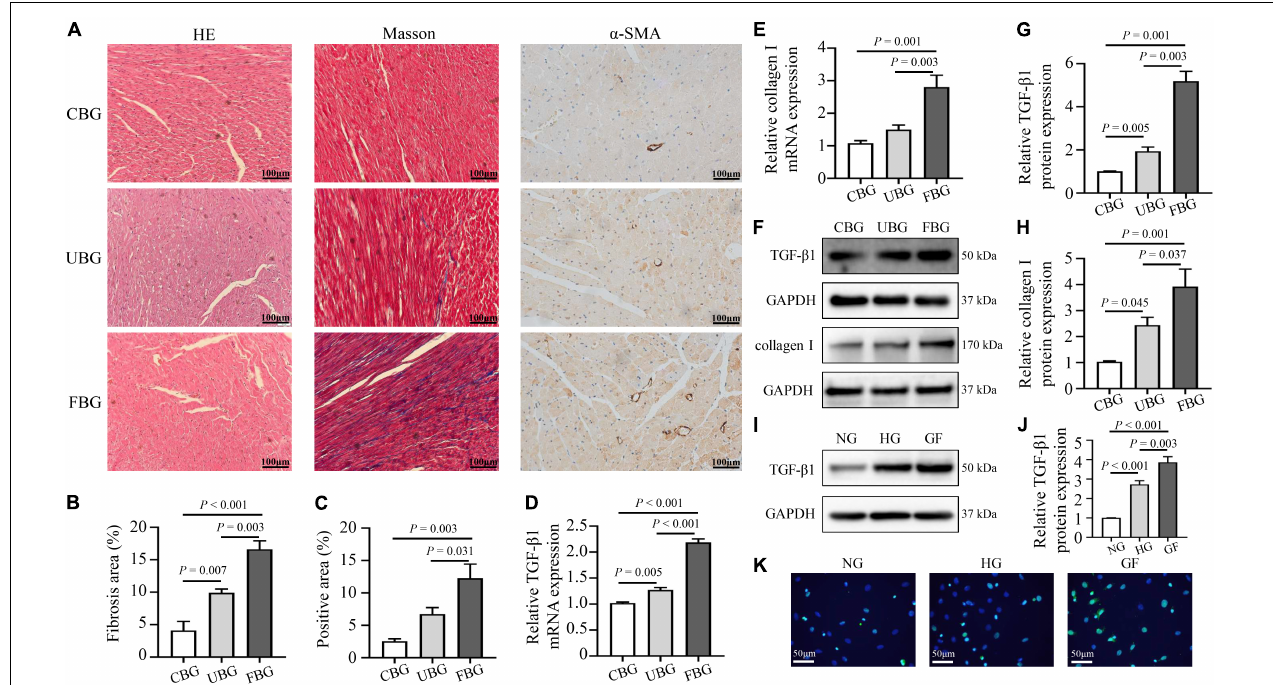
FIGURE 2 | Glucose fluctuations promoted myocardial fibrosis. (A–C) Representative images of hematoxylin and eosin (HE) staining for myocardial tissue in the CBG, UBG, and FBG groups ( n = 3 per group). Representative images of myocardial fibrosis and fibrosis area (%) in the CBG, UBG, and FBG groups ( n = 3 per group). Representative images of immunohistochemistry staining of α -SMA and positive area (%) in the three groups ( n = 3 per group). (D,E) The mRNA levels of TGF- β 1 and collagen I in rat hearts of the three groups ( n = 4 per group). (F–H) The protein expressions of TGF- β 1 and collagen I in rat hearts of the three groups ( n = 4 per group). (I,J) The protein expressions of TGF- β 1 in NRCFs of the NG, HG and GF groups ( n = 4 per group). (K) Immunofluorescence staining of intracellular TGF- β 1 in the NG, HG, and GF groups ( n = 3 per group).